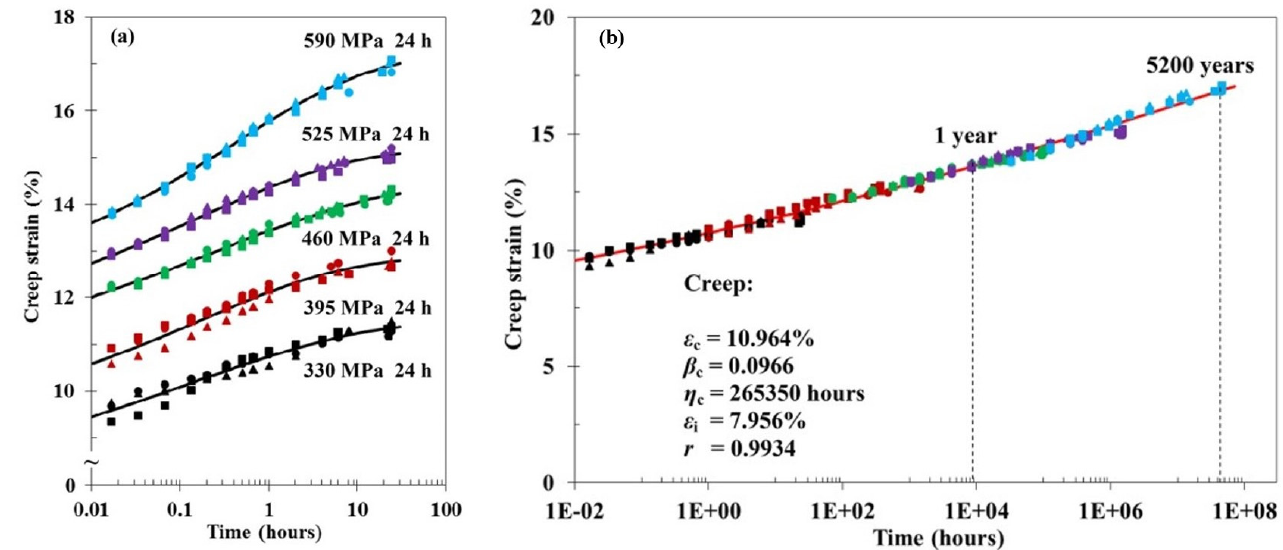
Figure 5. Creep curves for PA6,6 fibres at various creep stresses ( a ) and master curve obtained by TSSP ( b ). Adopted with permission from Ref. [59]. Copyright 2017 Willey.